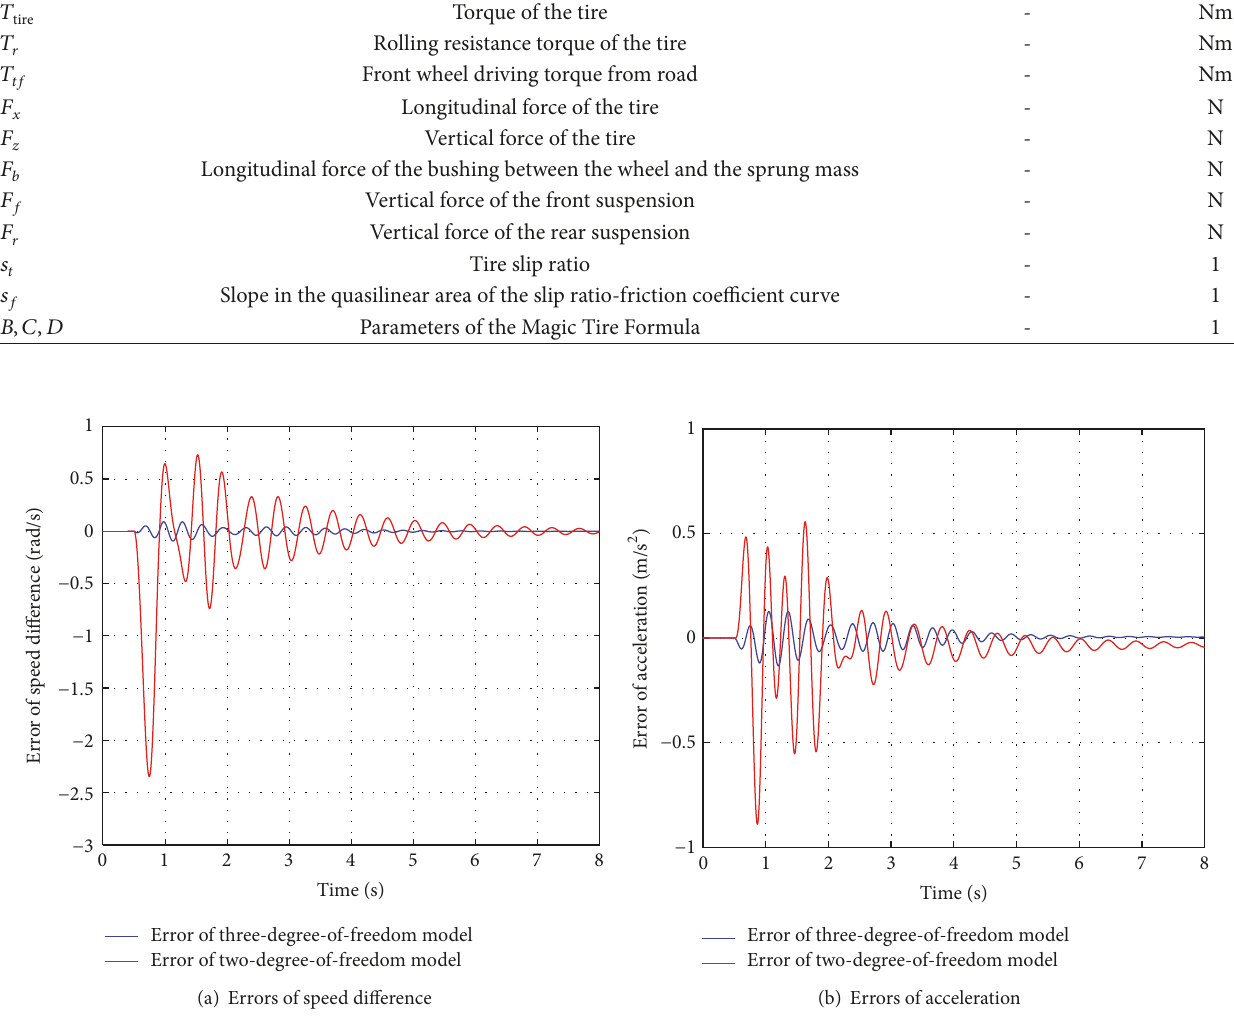
Figure 26: Errors of the two reduced-order